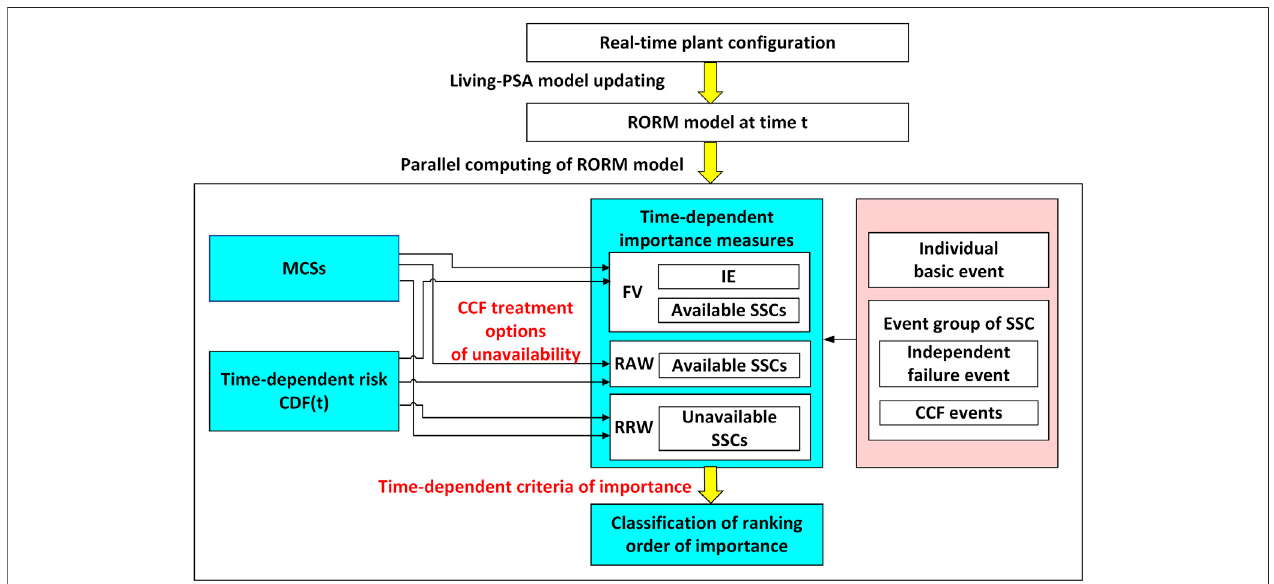
FIGURE 2 | The evaluation process of time-dependent importance